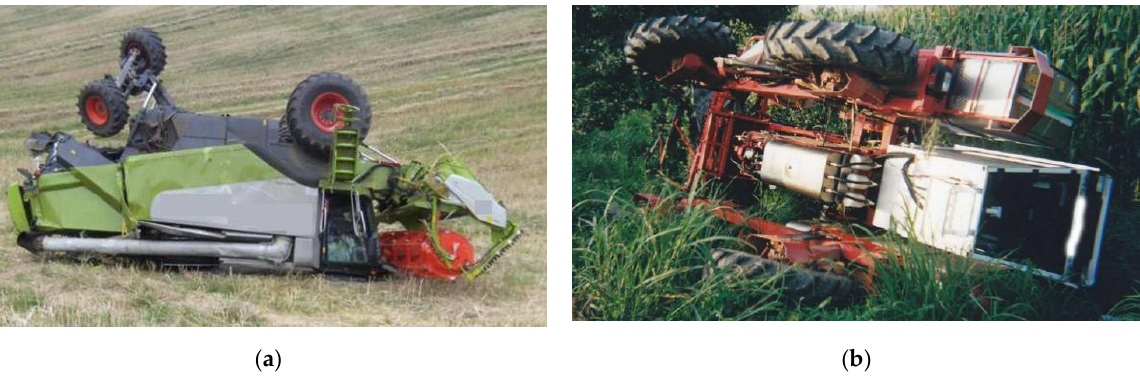
Figure 1. SPAM loss of stability during field operation: ( a ) roll-over; ( b ) tip-over.